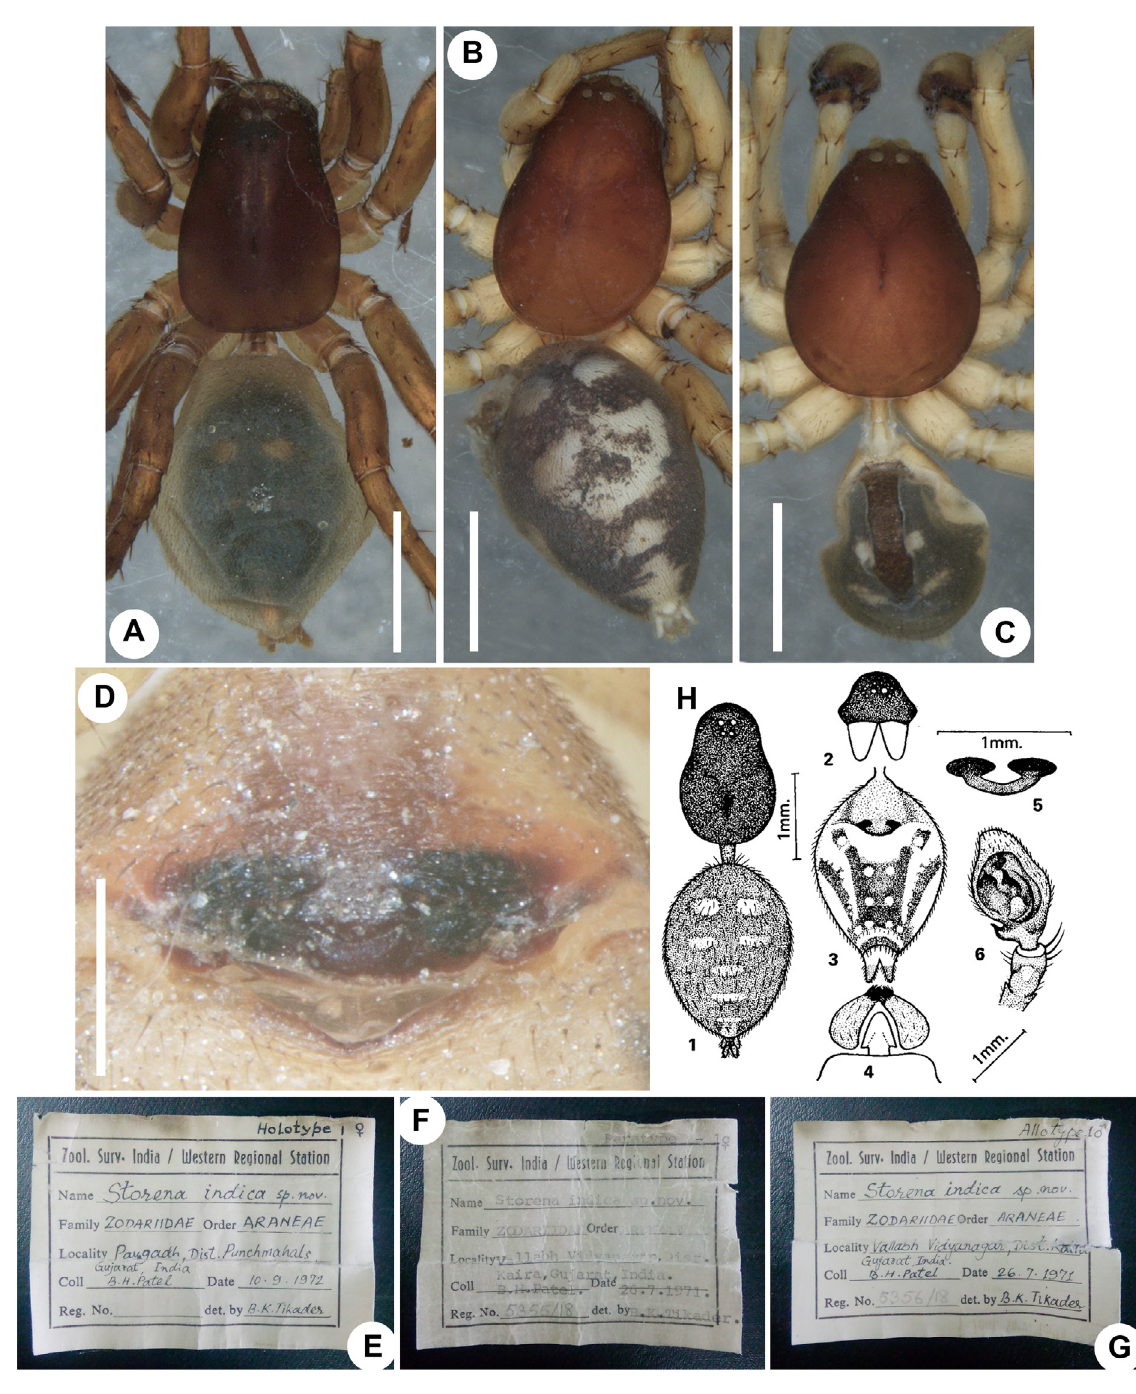
Fig. 10. Mallinella indica (Tikader & Patel, 1975) comb. nov., ♂♀, holotype, paratype and allotype of Storena indica Tikader & Patel, 1975. A , D , E . Holotype, ♀ (NZC-ZSI-5354/18). A . Habitus, dorsal view. D . Epigynum, ventral view. E . Type label. B , F . Paratype, ♀ (NZC-ZSI-5355/18). B . Habitus, dorsal view. F . Type label. C , G . Allotype, ♂ (NZC-ZSI-5356/18). C . Habitus, dorsal view. G . Type label. H . Original illustrations of S. indica adapted from Tikader & Patel (1975). Scale bars: A–C = 2 mm; D = 0.5